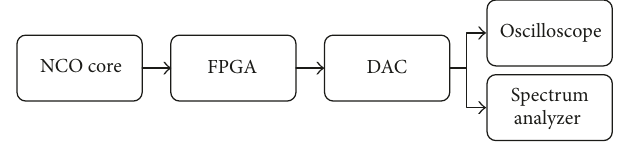
Figure 21: A block diagram showing experimental setup for DAC interface core.